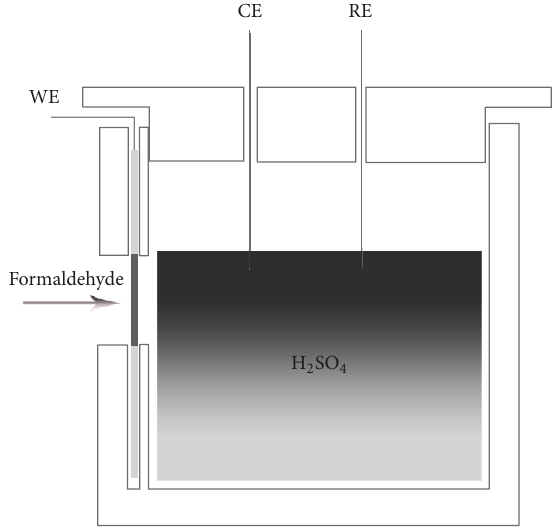
Figure 2: Schematic illustration of formaldehyde gas sensor.